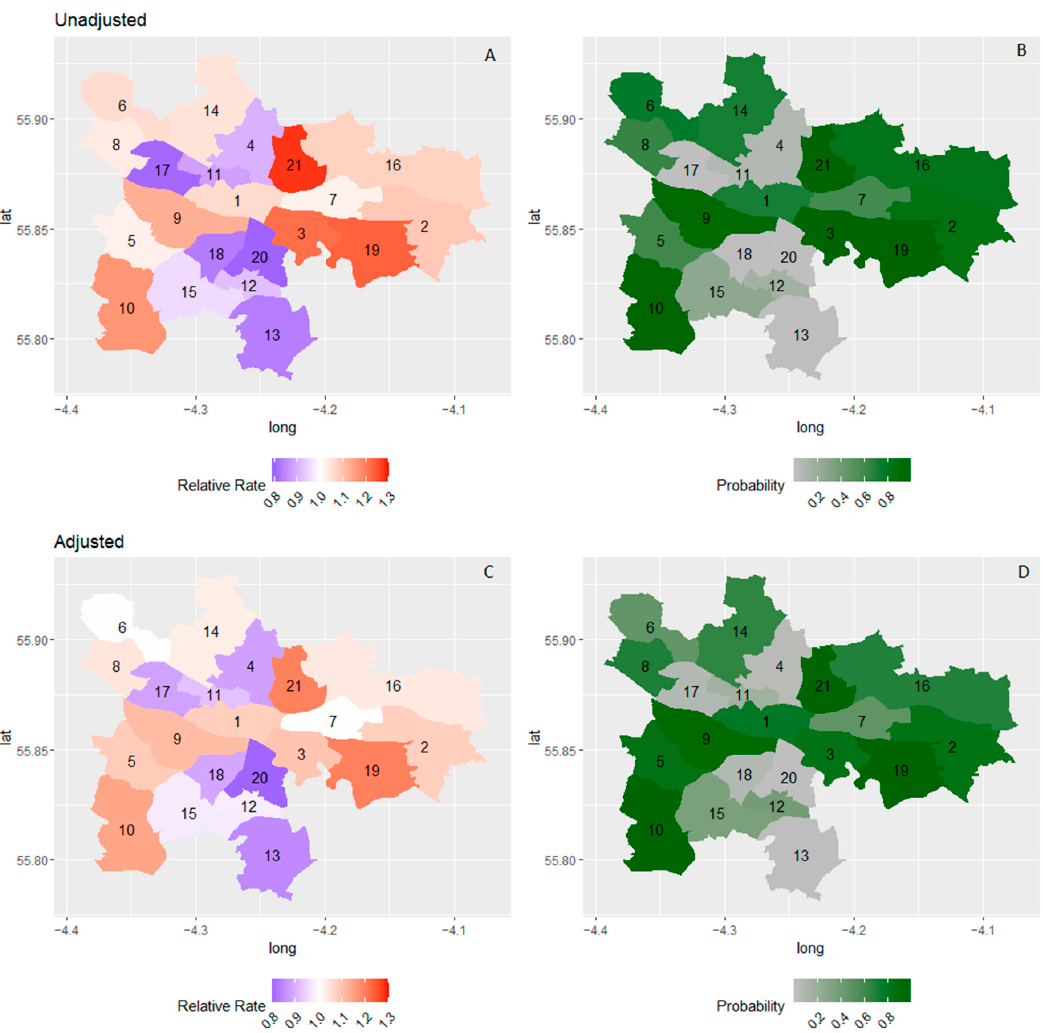
Figure 2. Relative rate increase in number of children with high total SDQ scores before ( A ) and after ( C ) and adjustment and exceedance probability before ( B ) and after ( D ) and adjustment for sex, age, cohort, and deprivation. 1. Anderston/City, 2. Baillieston, 3. Calton, 4. Canal, 5.